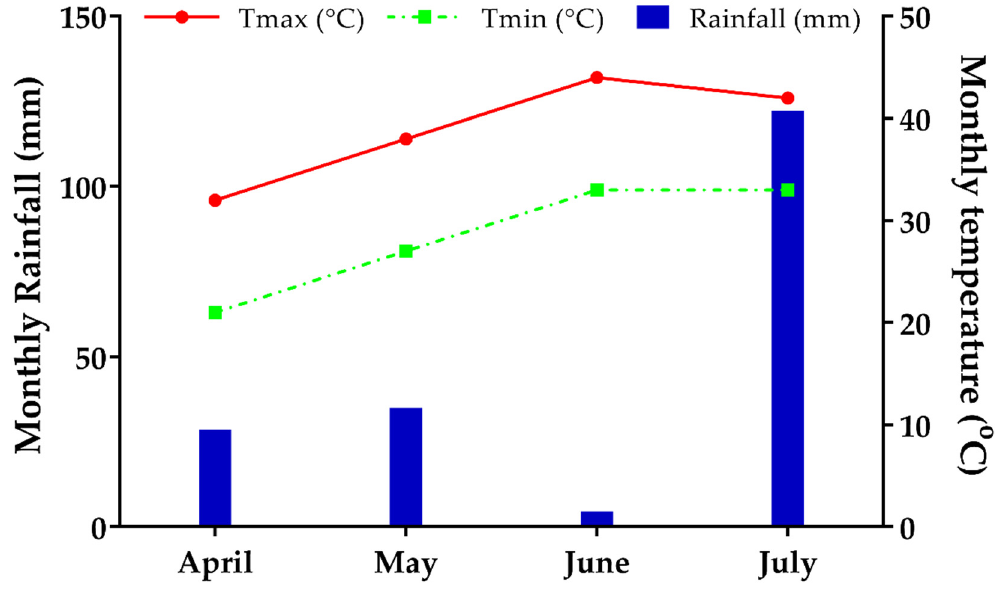
Figure 1. Monthly rainfall, and minimum and maximum air temperatures during the sweet maize growing season (April–July 2021) in Peshawar (Pakistan). growing season (April–July 2021) in Peshawar